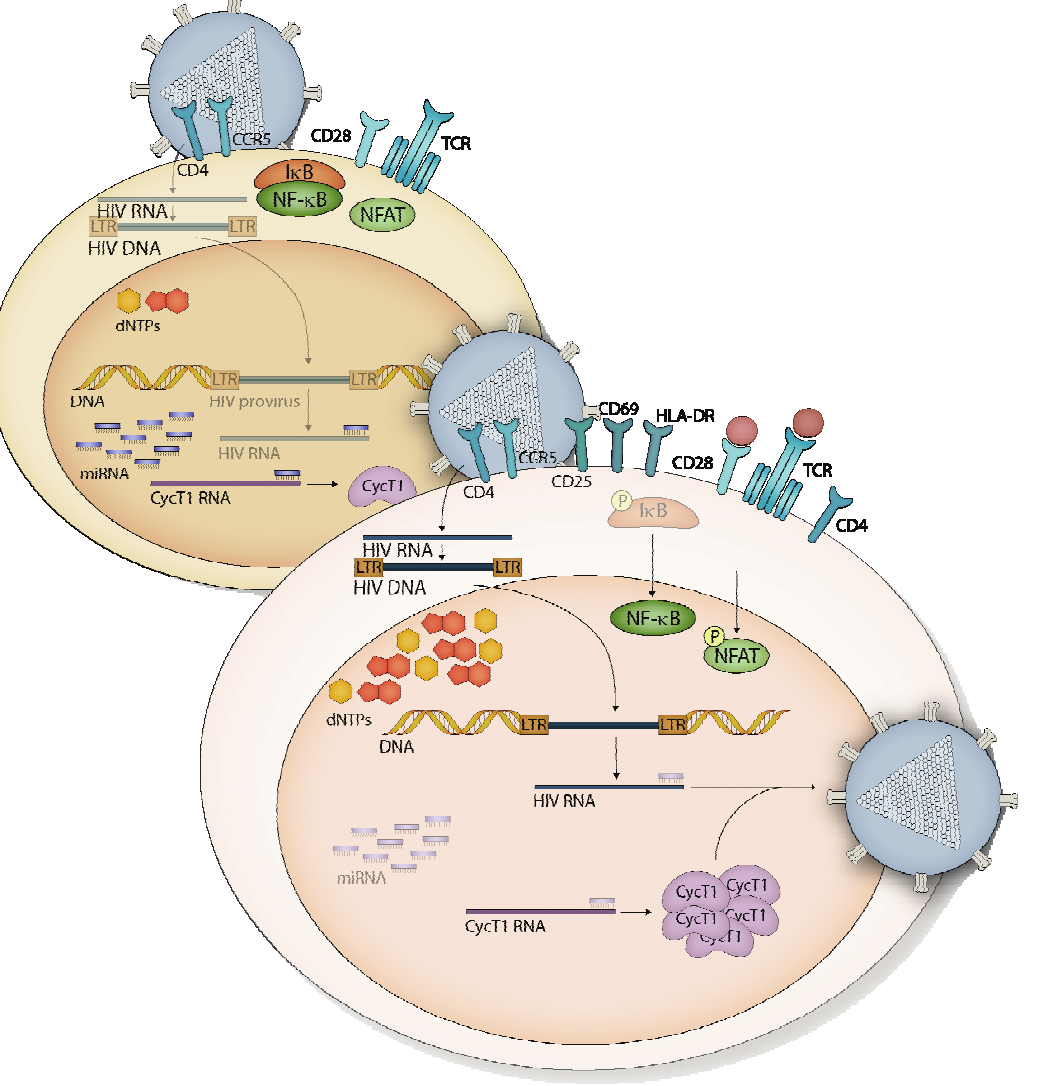
Figure 1. Mechanisms of HIV-1 restriction in resting CD4 + T cells and HIV-1 permissivity in activated CD4 + T cells. HIV-1 infection is blocked at several early steps in resting CD4 + T cells, including reverse transcription, integration, and proviral transcription. Low nucleotide levels and cytoplasmic sequestration of key factors which mediate proviral transcription both contribute to restriction. Furthermore, miRNAs which target HIV-1 RNA are expressed at high levels in resting cells, along with miRNAs which repress translation of the Tat co-factor Cyclin T1. Following activation, in this case depicted as engagement of the TCR and CD28 receptor, I κ B is phosphorylated and degraded, freeing NF- κ B to translocate to the nucleus. NFAT phosphorylation also results in its nuclear re-localization. Nucleotide levels undergo an increase, and reverse transcription of the HIV-1 genome proceeds efficiently, as does integration into host chromosomal DNA, and transcription of the provirus. This latter process is aided by increased levels of Cyclin T1, as Cyclin T1-targeting miRNAs (and HIV-targeting miRNAs) are downregulated after